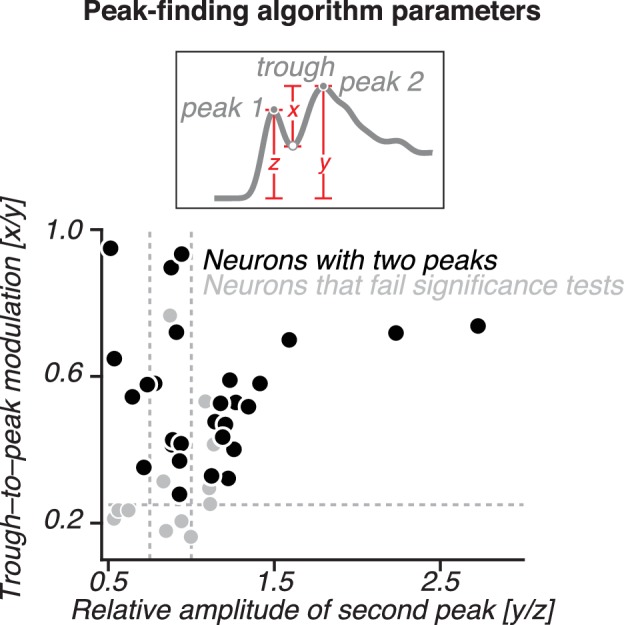
Distribution of parameter values for the peak-finding algorithm.The amplitude of the putative second peak relative to the initial transient (y/z, see inset) is plotted against the size of the trough-to-peak modulation (x/y) for 42 neurons that had a second peak with a sizable amplitude and trough-to-peak modulation (i.e. for neurons with y/z > 0.5 and x/y > 0.15; see Figure 6—figure supplement 1B for details). Thirty neurons that also passed the statistical test are shown in black. Dotted lines indicate alternative threshold criteria for the peak amplitude and modulation parameters used in Figure 8—figure supplement 4 to classify neurons as having two peaks.